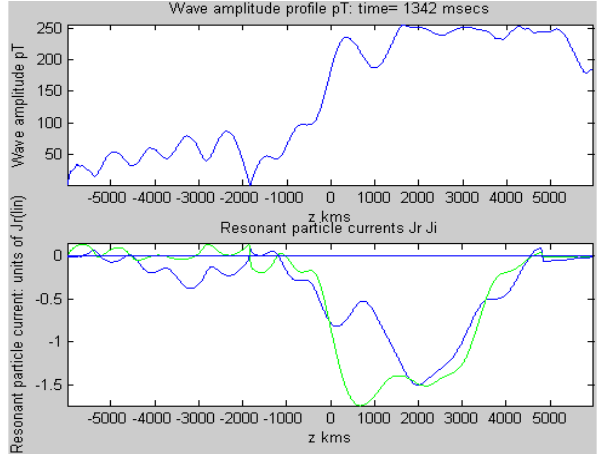
Fig. 8. Fig. 8. Spatial structure, as functions of the distance z from the geomagnetic equator, of a rising frequency chorus element genera- tion region (GR) for the case Ne=3 electrons/cc. It is evident that the quasistatic wave amplitude envelope exhibits modulation due to resonant sidebands. The structure is sustained by the J r field (blue curve), and the J i field (green curve) continuously shortens the wavelength through the term d/dz(J i /R), which leads to an emis- sion of rising frequency. A substantial contributor to the sweep- ing frequency is the gradient of wavenumber/frequency established across the GR.